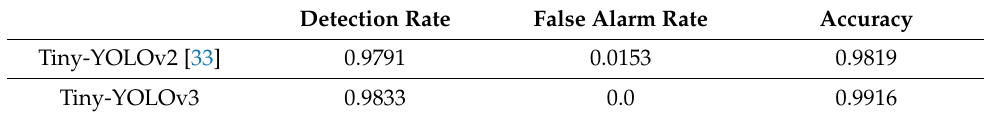
Table 5. Performance comparison between Tiny-YOLOv2 and